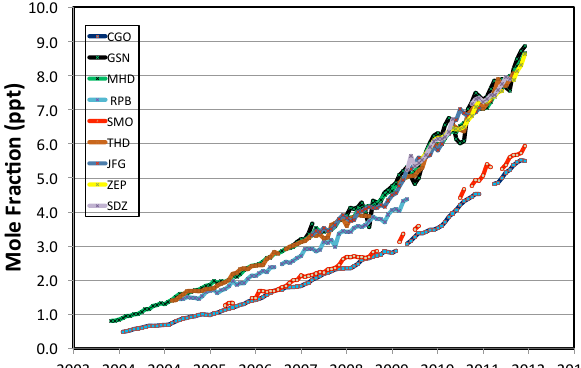
Figure 2. Baseline monthly mean HFC-32 mole fractions (ppt) from in situ Medusa GC-MS measurements at AGAGE stations: Cape Grim Observatory (CGO), Gosan (GSN), Mace Head (MHD), Ragged Point (RPB), Samoa (SMO), Trinidad Head (THD), Jungfraujoch (JFG), Zeppelin (ZEP) and Shangdianzi (SDZ).